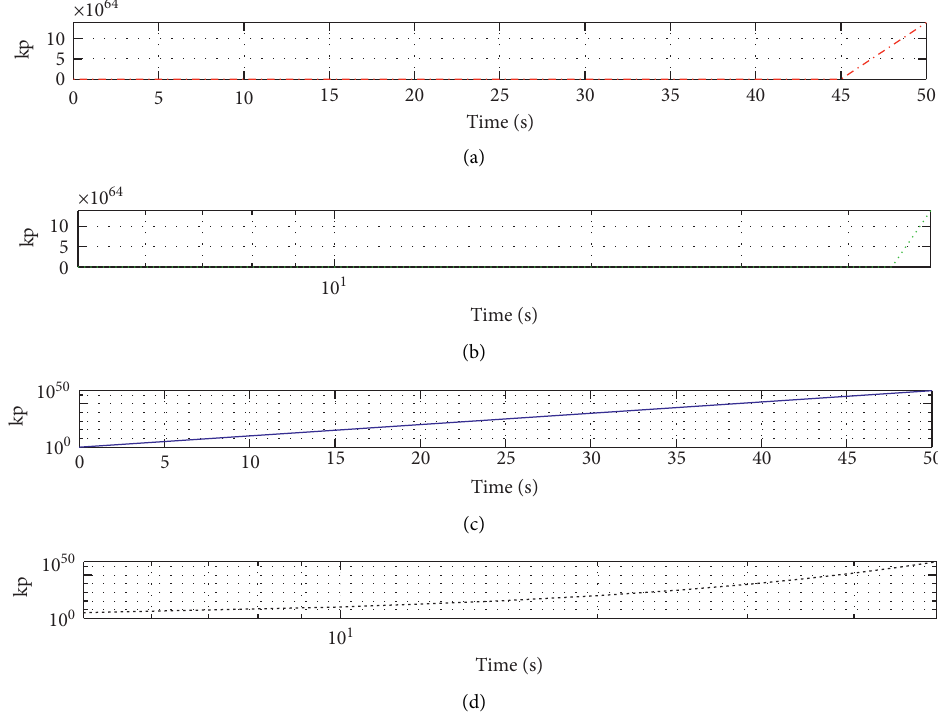
Figure 6: Online teaching parameter training based on hierarchical PSO-BP neural network.